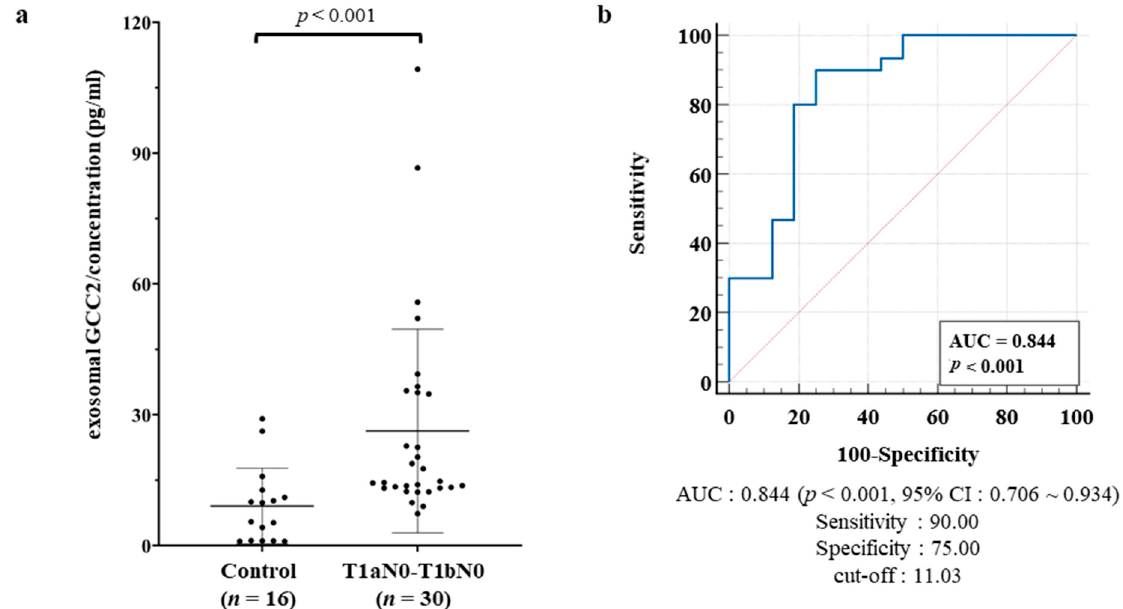
Figure 4. Evaluation of the exosomal GCC2 protein as a diagnostic biomarker for patients with early-stage lung cancer. ( a ) Exosomal GCC2 protein concentrations in the healthy control group ( n = 16) and patients with T1aN0-T1bN0 lung cancer ( n = 30) determined by ELISA. ( b ) ROC curve based on the exosomal GCC2 protein levels to distinguish patients with early NSCLC from normal healthy controls. An independent Student’s t -test and the Jonckheere–Terpstra test were used for statistical validation.